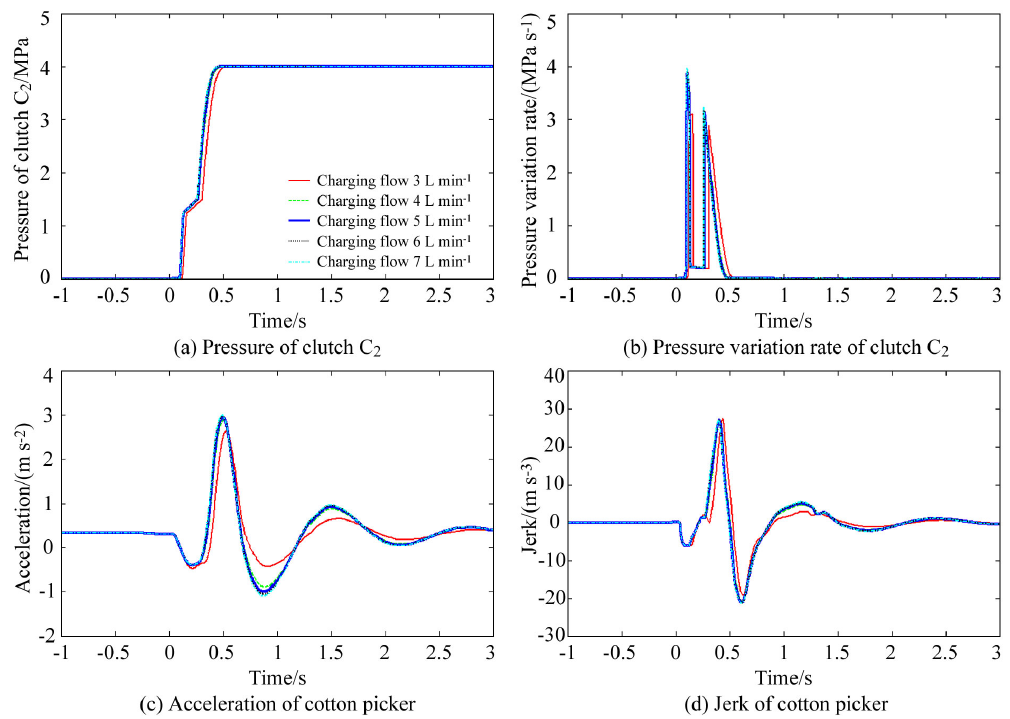
Figure 7. Influence of charging flow on the shift quality of the cotton